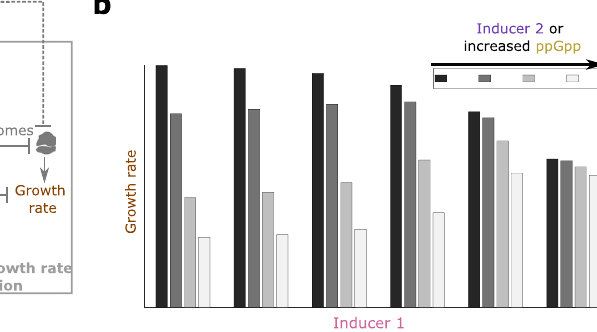
Fig. 1b. Expression of SpoTH also places a load on the cell via resource (e.g.,ribosome)sequestration(dashed fl atheadedarrowinFig.1afrom SpoTH to ribosomes). Thus, once a suf fi cient amount of ppGpp has